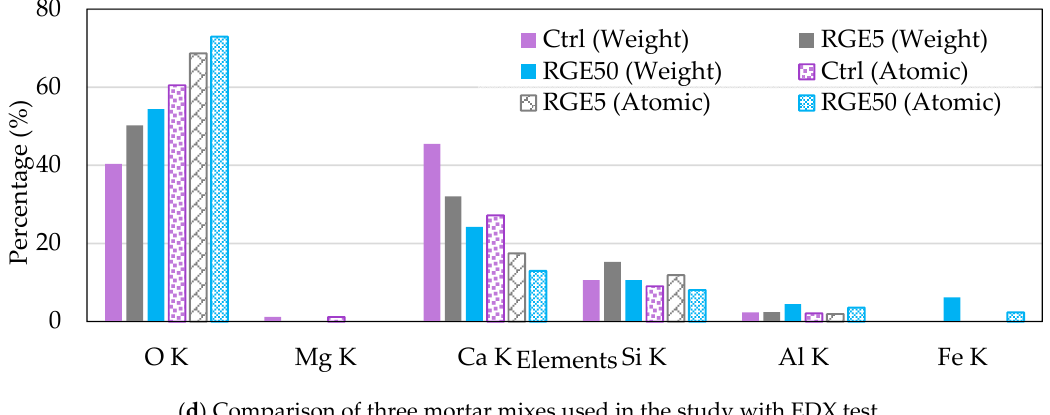
Figure 21. EDX analysis of mortar mixes.